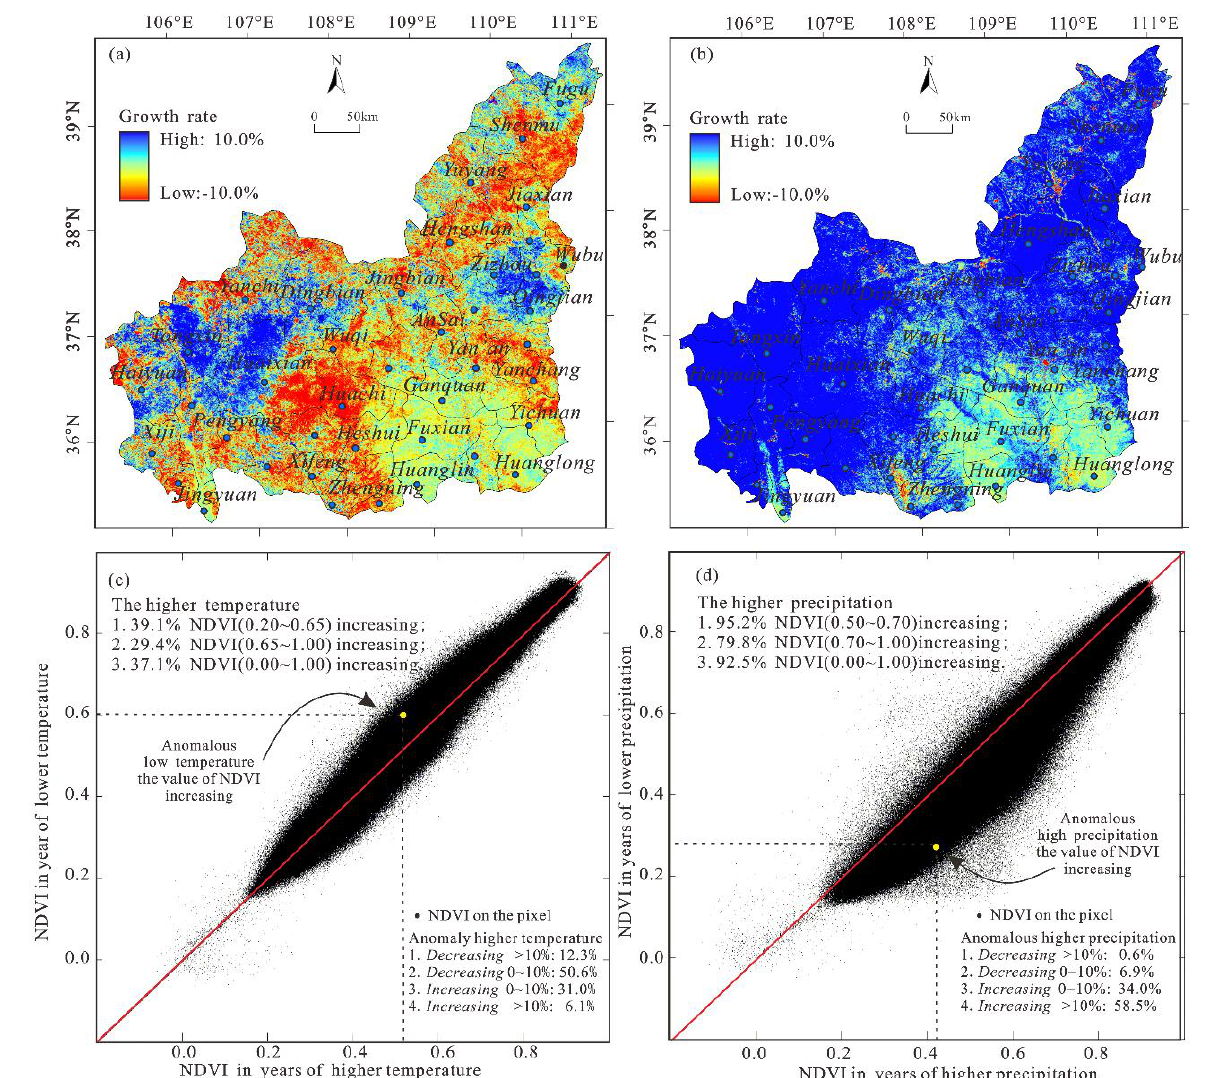
Figure 6. NDVI responses to anomalous higher temperatures and precipitation in the Shaanxi-Gansu-Ningxia region. ( a ) The NDVI response to higher temperature; ( b ) The NDVI response to higher precipitation; ( c ) A scatter diagram of the NDVI response to temperature; ( d ) A scatter diagram of the NDVI response to